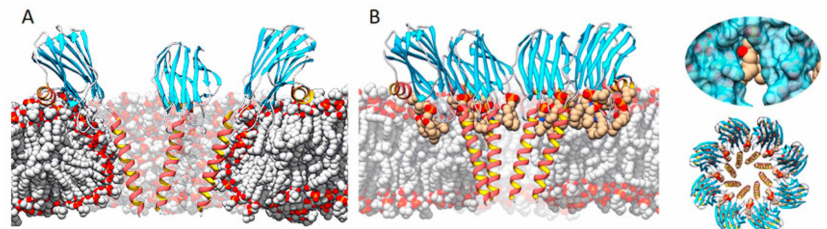
Figure 4. Two of the main models representing the pore structure of actinoporins. ( A ) A tetrameric one in which the membrane adopts a toroidal shape around the pore walls (made using StnII model 1GWY fitted to the structure of FraC from model 4TSY), and ( B ) an octameric lipid–protein structure (FraC pore, PDB ID: 4TSY) in which lipids (carbon atoms in tan color) are accommodated through pore wall fenestrations. Inserts on the right show a close-up of a lipid on a fenestration (top) and a top view of the octameric complex (bottom). Adapted from [32]. The α -helices are depicted in red and gold, β -sheets in blue, nonperiodic structures in grey. Bulk lipids are depicted in grey (carbon atoms) and red (oxygen